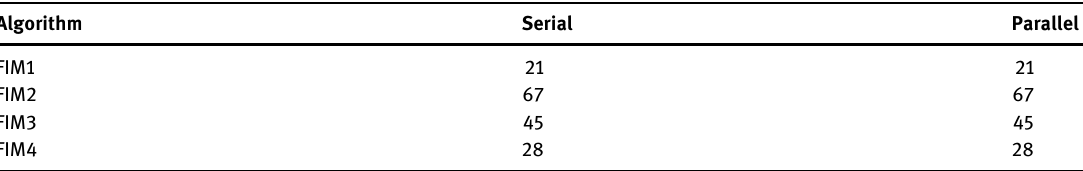
Table 2: Data mining results of serial and parallel for 150 M fi les Algorithm